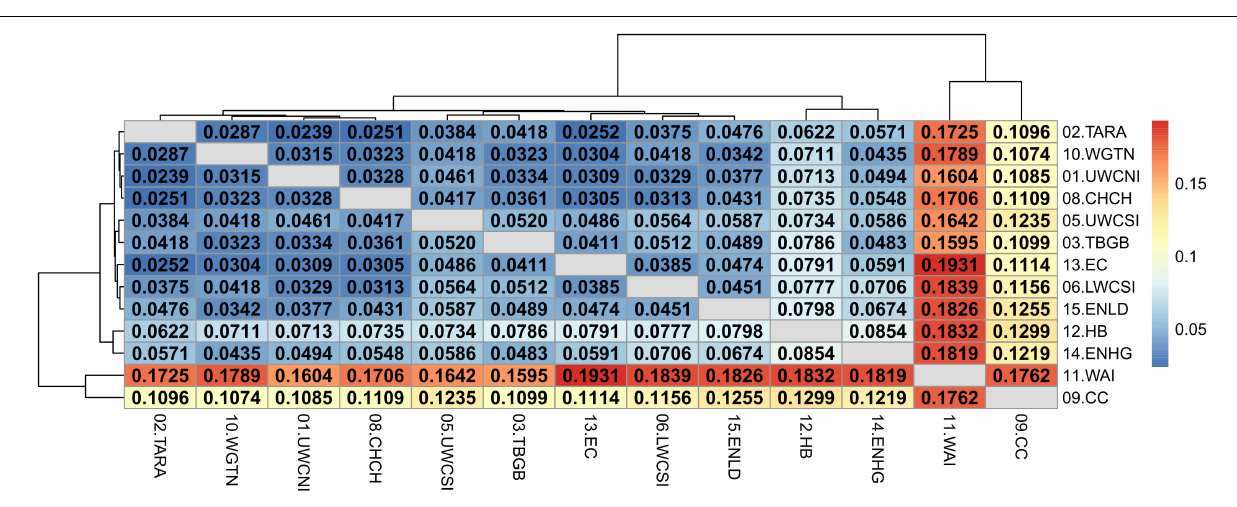
FIGURE 9 | Heatmap of pairwise weighted F ST estimates (corresponding to the values above and below the diagonal) among sample locations of the adaptive SNP dataset, minus Tasmania. The dendrogram shows the inferred relationship between sample locations. Significant p -values ( < 0.01 after false discovery rate correction) are in